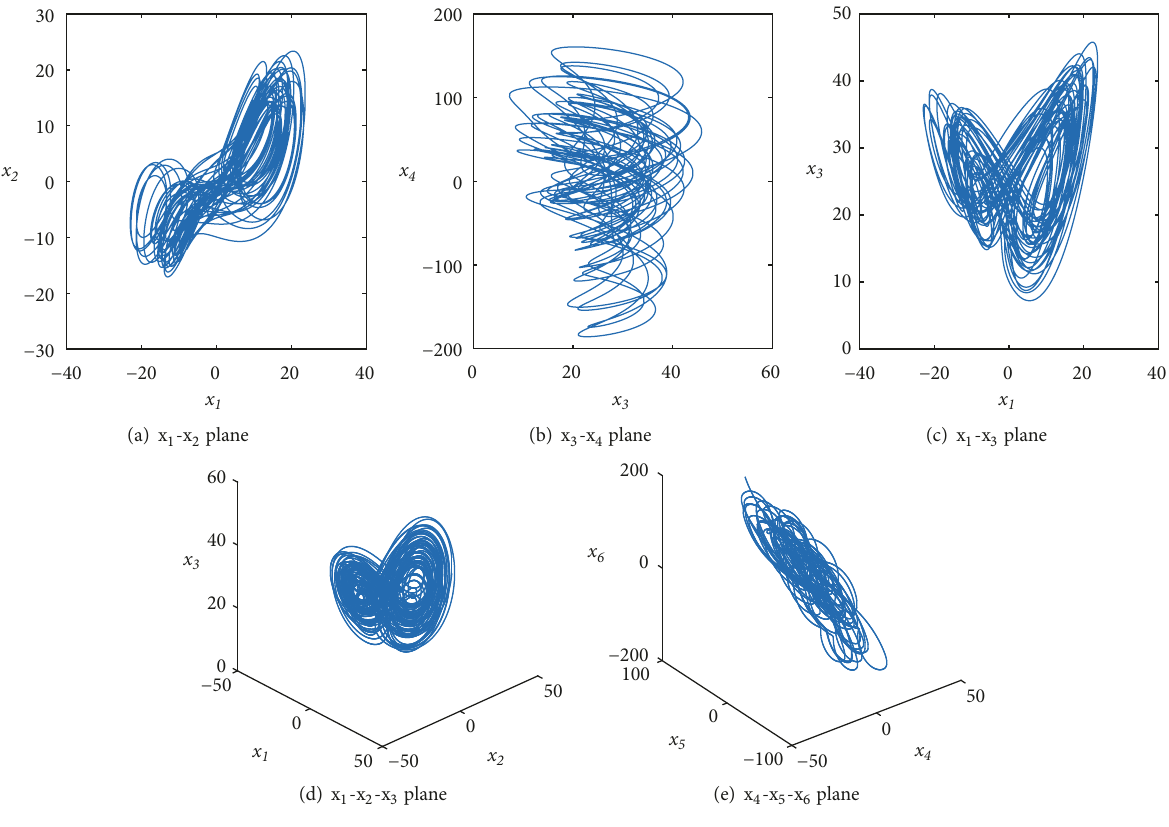
Figure 1: Hyperchaotic attractor of the 7D Lorenz hyperchaotic system (1).